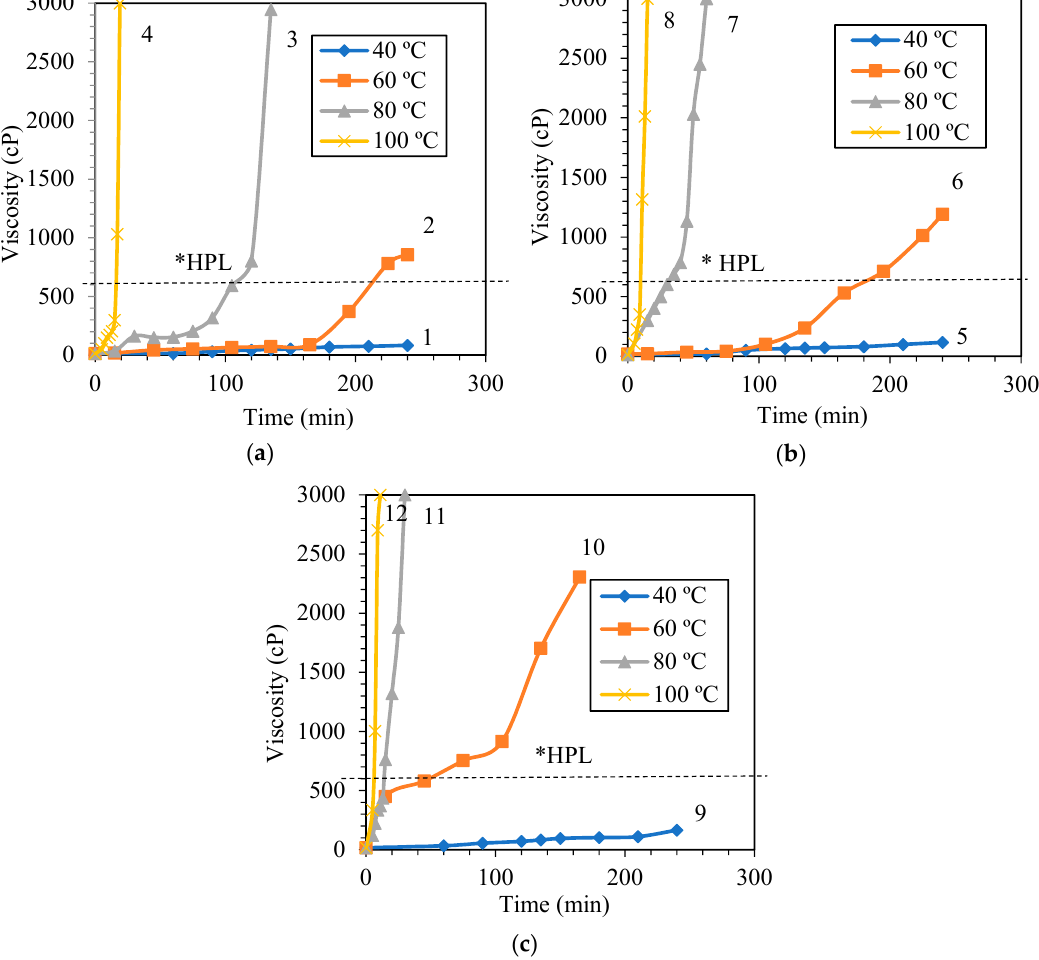
Figure 4. Effect of synthesis temperature on the dynamic viscosity of PF resins prepared at different molar ratios of P to F ( a ) PF I, ( b ) PF II and ( c ) PF III. * Dashed line refer to high pressure laminate (HPL) standard requirement for viscosity [22].